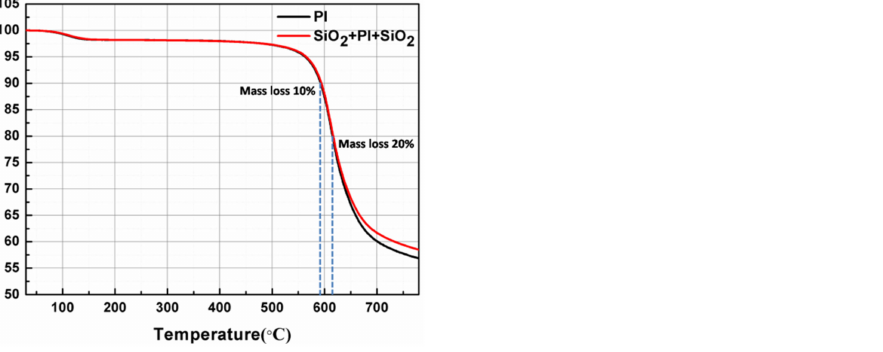
Figure 9. The TGA curves of PI membranes before and after coated with SiO 2 antireflective membrane in nitrogen.